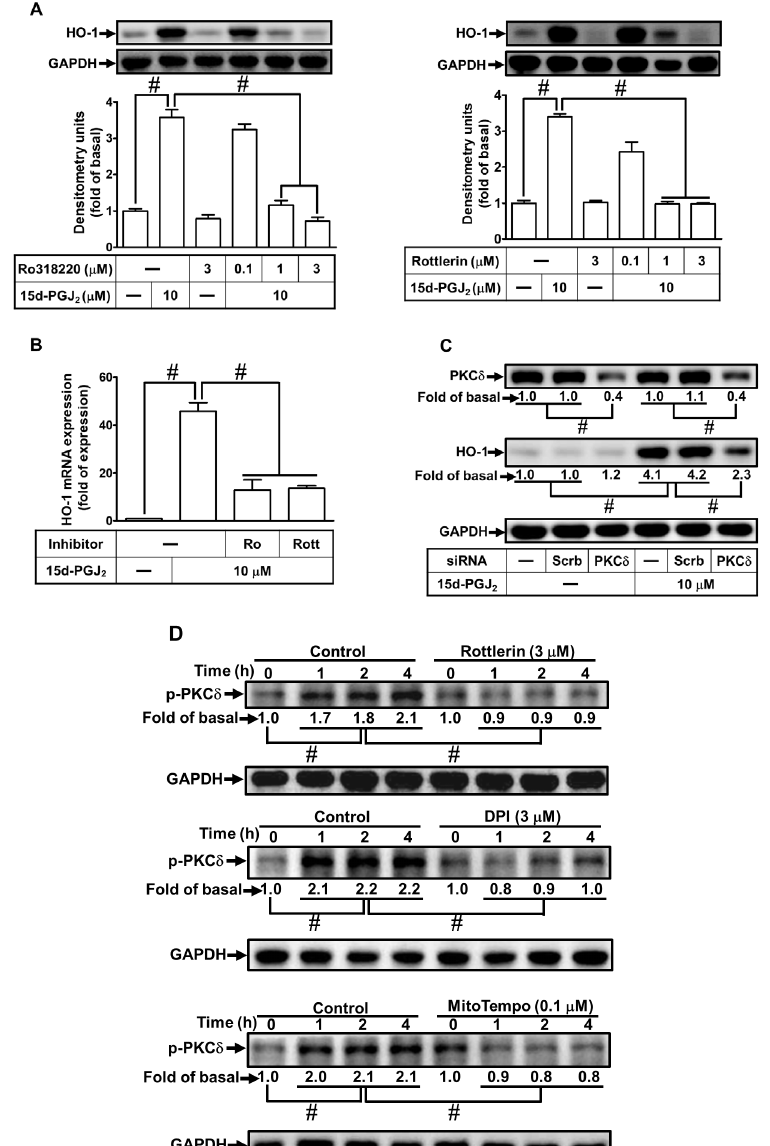
Figure 3. Involvement of PKC δ in HO-1 upregulated by 15d-PGJ 2 in bEnd.3 cells. ( A ) The indicated doses of Ro318220 or Rottlerin pretreated cells for 1 h before cells were incubated with 15d-PGJ 2 (10 µ M) for 6 h. To determine the HO-1 expression, the cell lysates were assessed by Western blot with GAPDH as an internal control. ( B ) The cells were pretreated with Rottlerin (3 µ M) or Ro318220 (3 µ M) for 1 h and then incubated with 10 µ M 15d-PGJ 2 for 4 h. mRNA levels of HO-1 were quantified by real-time PCR. ( C ) The cells were transfected with scrambled or PKC δ siRNA and then challenged with 15d-PGJ 2 (10 µ M) for 6 h. The PKC δ and HO-1 protein expression were assessed by Western blot with GAPDH as an internal control. ( D ) The cells were preprocessed with Rottlerin (3 µ M), DPI (3 µ M), or MitoTempo (100 nM) for 1 h and then challenged by 15d-PGJ 2 (10 µ M) for 1, 2, and 4 h. The phosphorylation of PKC δ was assessed by Western blot with GAPDH as an internal control. Data are expressed as the mean ± S.E.M. of three independent experiments. # p < 0.01, as compared with the basal level or 15d-PGJ 2 treatment alone. Abbreviations: Scrb: scrambled; Ro: Ro318220; Rott: